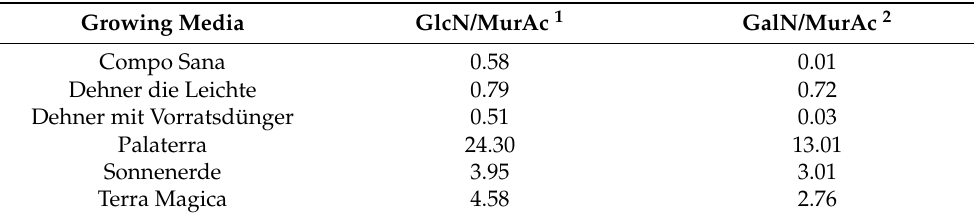
Table 3. Amino sugar ratios of glucosamine to muramic acid and galactosamine to muramic acid in the biochar- and peat based growing media under study.